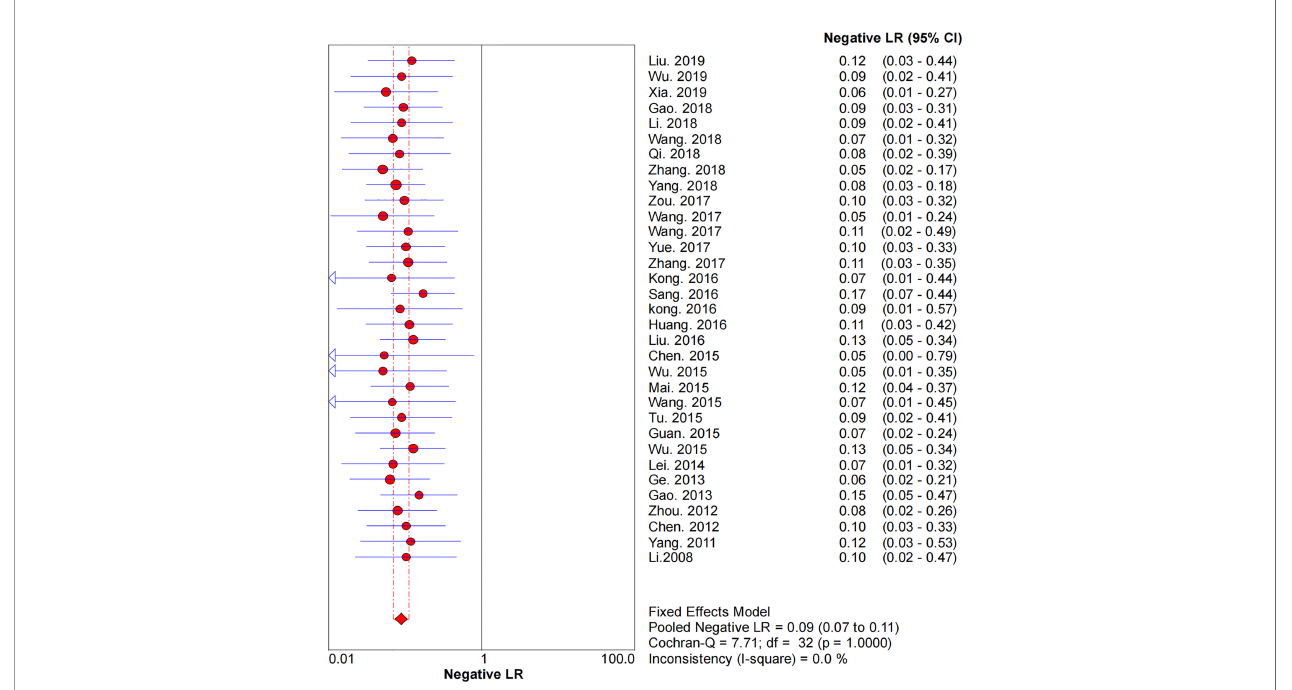
FIGURE 5 | Forest plot of pooled NLR of the diagnosis value of CNSs in SLNB of breast cancer. 95% CI, 95% con fi dence interval; NLR, negative likelihood ratio.